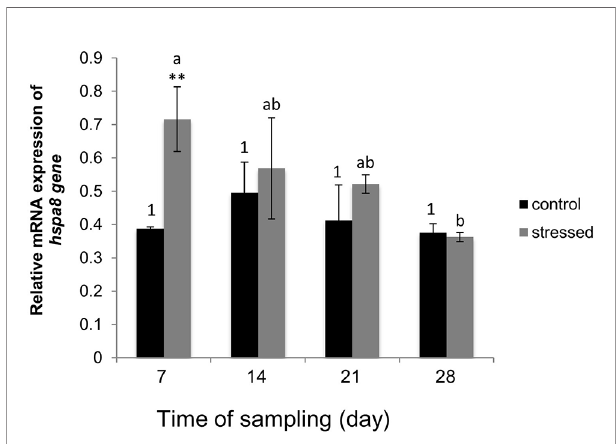
FIGURE 5 | Relative mRNA expression of hspa8 gene. The expression is relative to the geometric mean of two reference genes beta-actin and gapdh (glyceraldehyde 3-phosphate dehydrogenase). Asterisk denote a signi fi cant difference between the control and stressed group on day 7. The letters refers to the changes in expression between the stressed group on day 7 till 28. The number shows difference in expression between the control groups on day 7 till 28. The same letters and number means no change and different ltters and numbers indicate signi fi cant differences. Error bar shows error of the mean, n = 5, p < 0.05. Details about statistical analysis are mentioned in the statistic description in the Materials and Methods